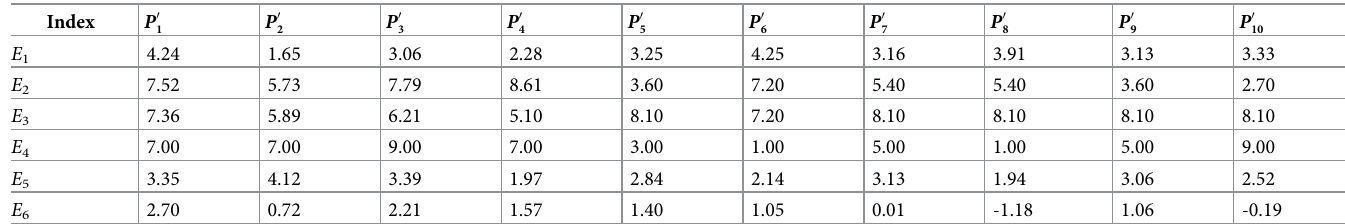
Table 6. Dynamic competency of 10 bid evaluation experts.